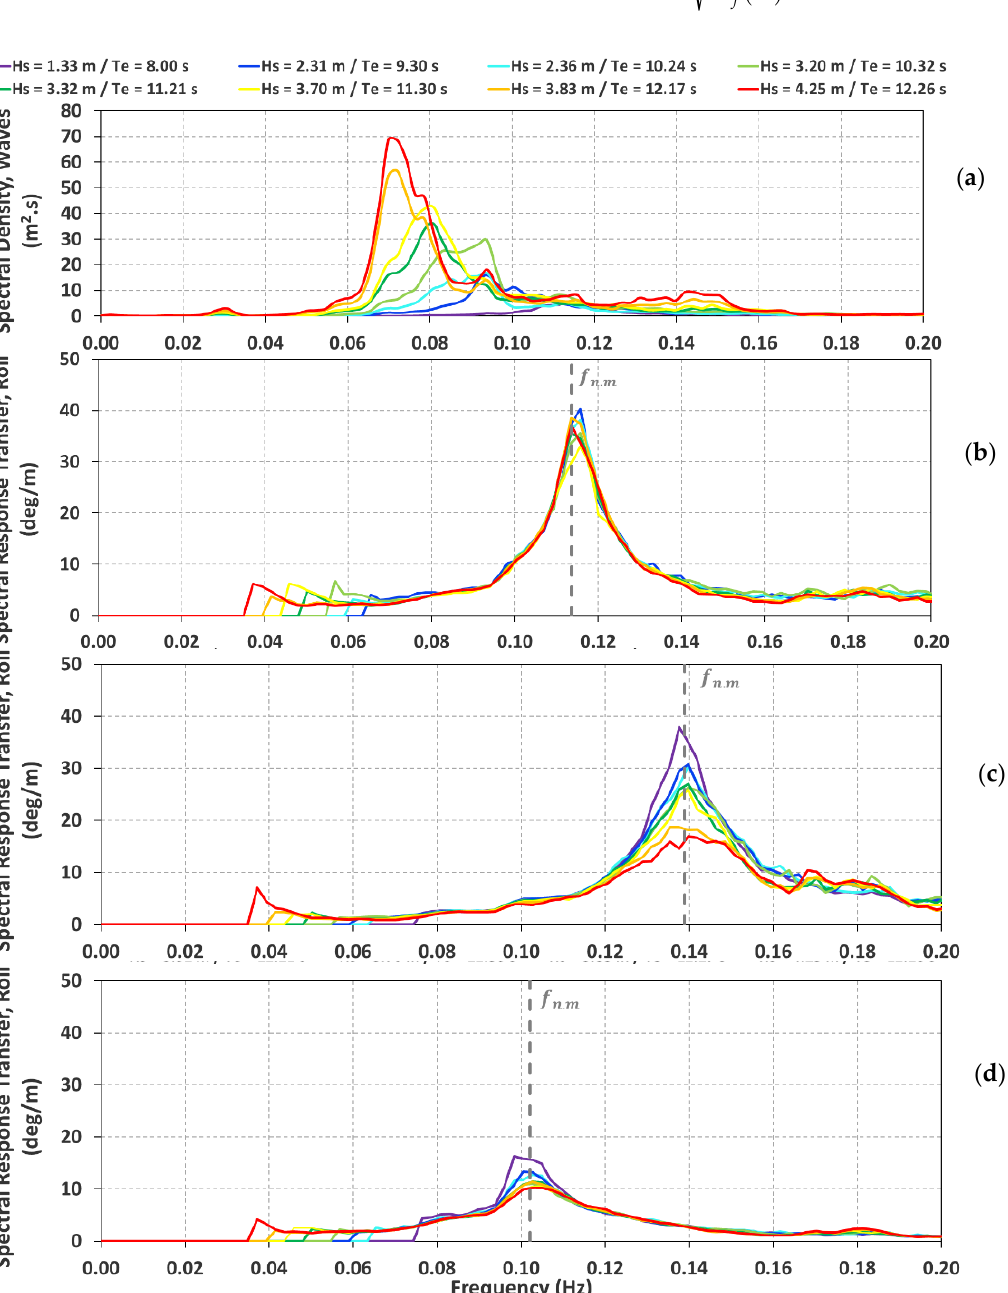
Figure 10. Sea-state spectra ( a ) and roll transfer functions for the V1 variants of the HC, HS and TP (( b – d ), in that order).